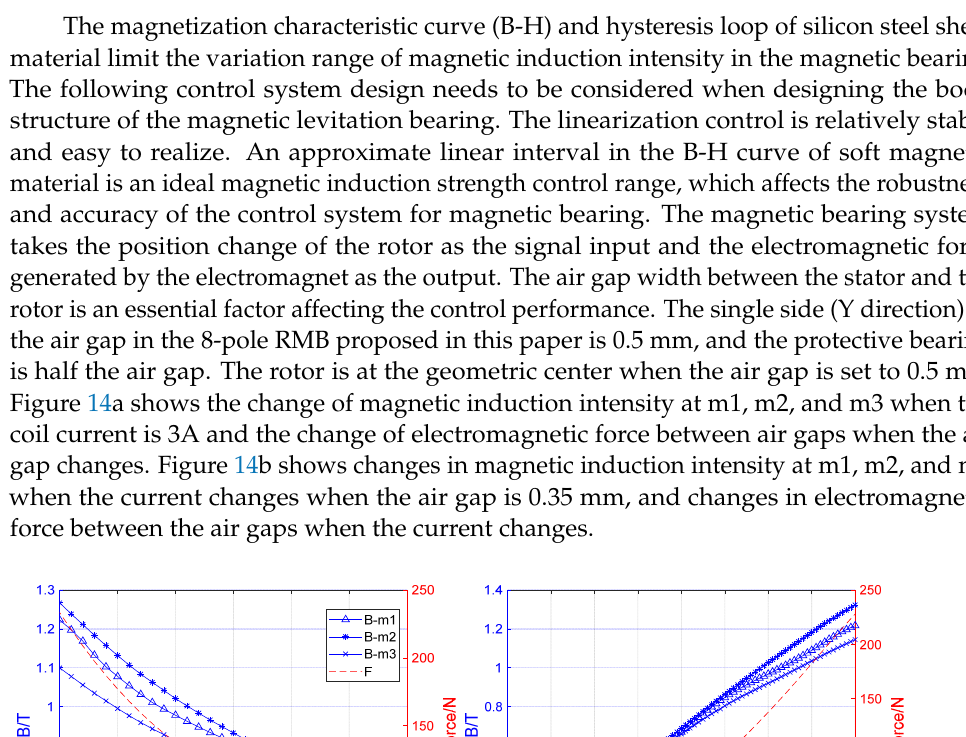
Figure 13. Magnetic field analysis of 8 ‐ pole RMBs magnetic pole.